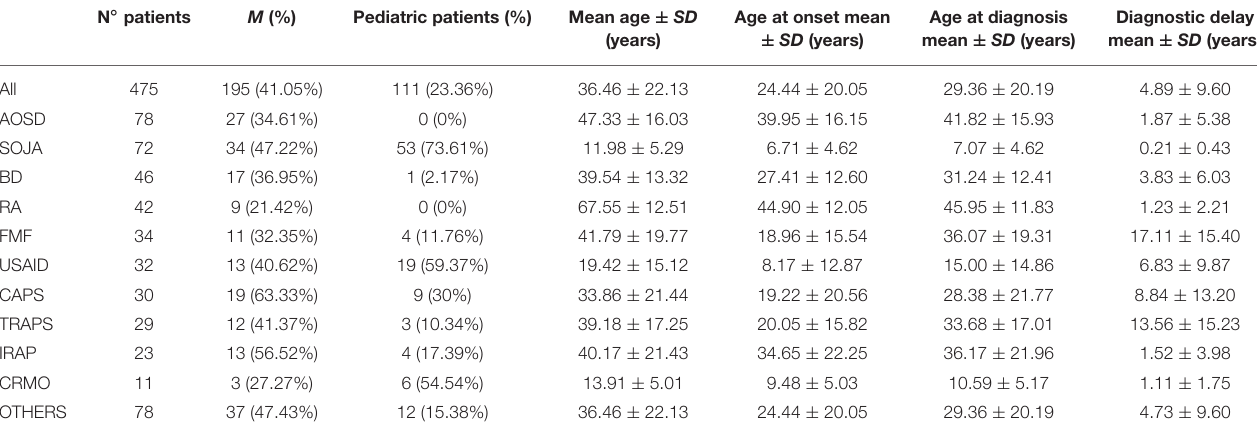
TABLE 1 | Demographic and clinical data of all patients enrolled in the study. N ◦ patients M (%) Pediatric patients (%) Mean age ± SD